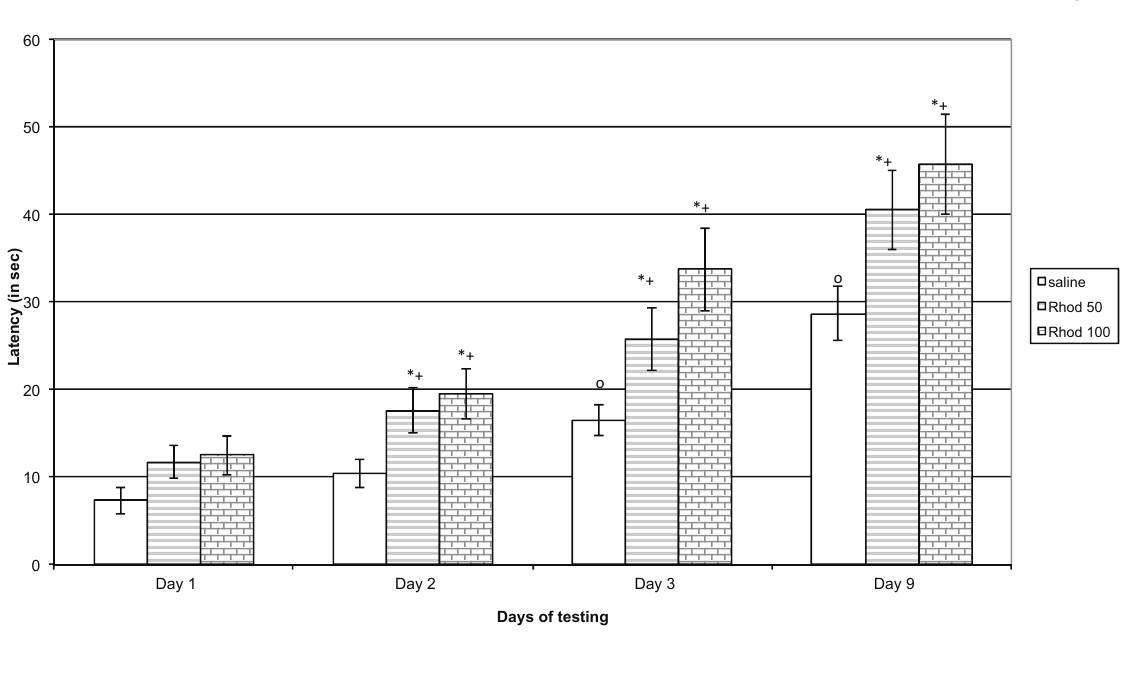
Figure 2. Effects of Rhodiola rosea extract on step-through test in naïve rats. On the Abscissa: 2-day learning session, short and long memory retrieval. Ordinate: the latency of reaction in seconds. o P<0.05 compared with the fi rst day control; * P<0.05 compared with the fi rst day of respective group; + P<0.05 compared with the same day